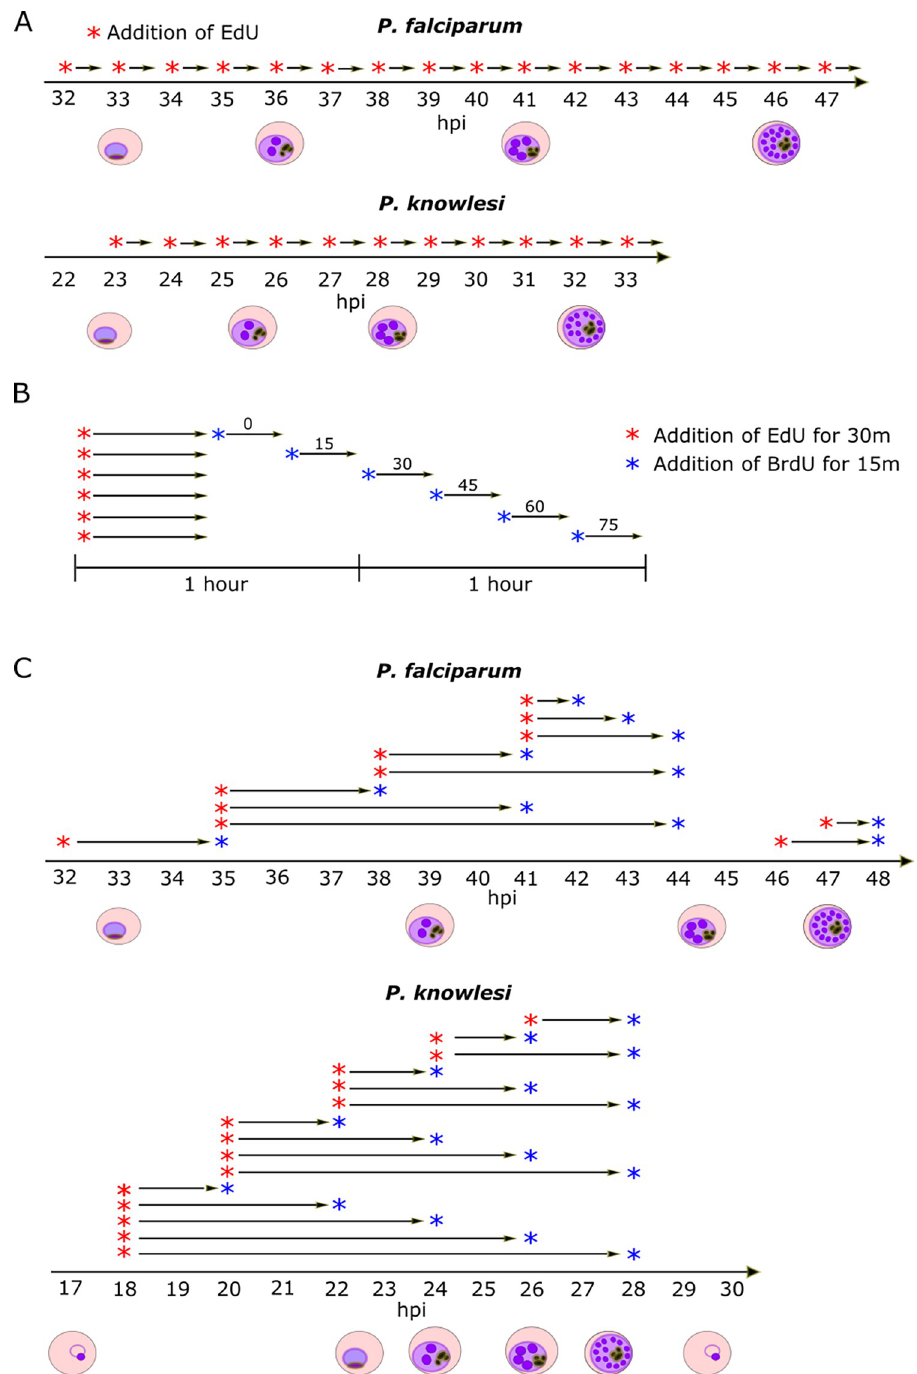
Fig 1. Schematics of experimental setup. A: Schematics of timecourses using single EdU pulse labels. B: Schematic of experiments using sequential pulses of two nucleotides (EdU and BrdU) to determine the length of each replicative round. C: Schematics of timecourses using 2-nucleotide (EdU and BrdU) interval pulse labels.